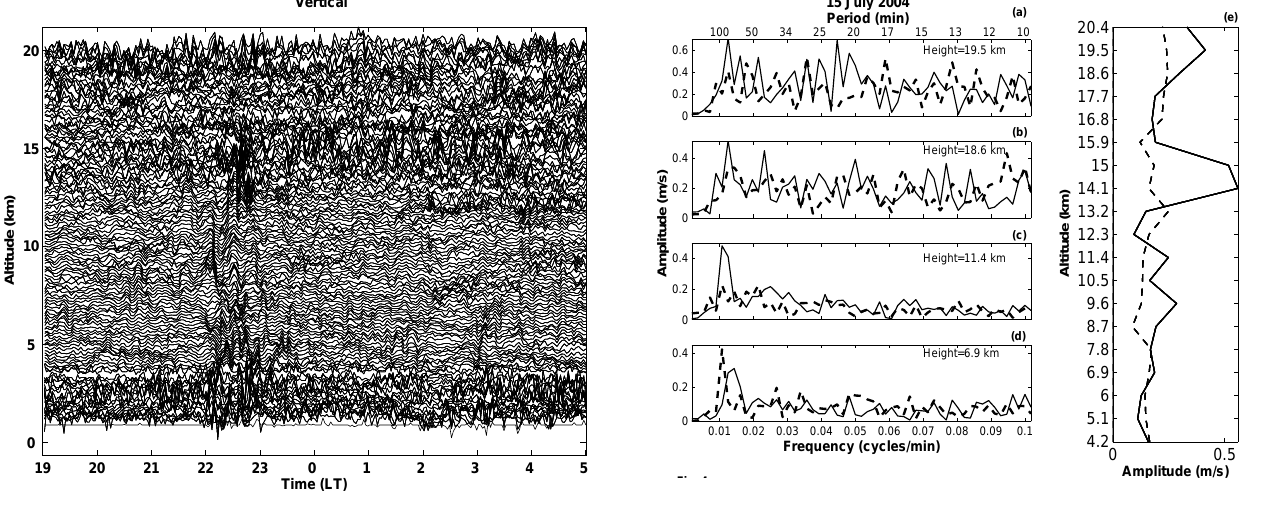
Fig. 3. Time series of vertical winds shifted by 0.15m/s for the same time interval.